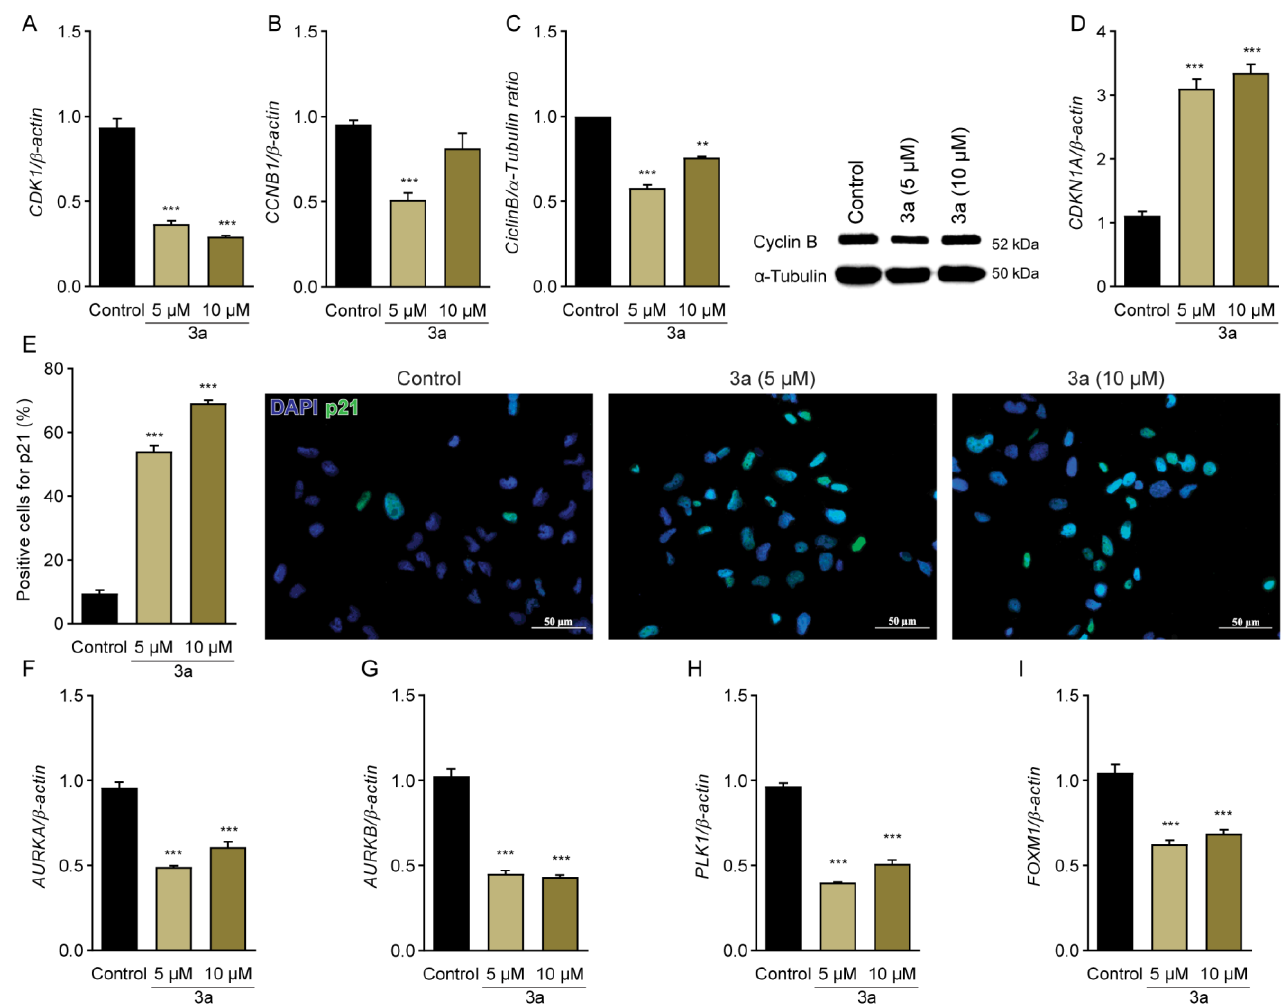
Figure 4. Compound 3a increased the expression of p21 and decreased the expression of aurora kinases. SK-MEL-147 cells were treated with 3a at 5 and 10 µM for 24 h and relative expression of target genes was evaluated by qPCR ( A – I ), immunoblot ( C ), or immunocytochemistry ( E ). ( A ) Relative CDK1 mRNA expression; ( B ) Relative CCNB1 mRNA expression; ( C ) Relative CCNB1 at protein levels; ( D ) Relative CDKN1A mRNA expression; ( E ) Frequency of p21-positive cells determined by immunofluorescence. Blue: DAPI; green: p21. ( F ) Relative AURKA mRNA expression; ( G ) Relative AURKB mRNA expression; ( H ) Relative PLK1 mRNA expression; ( I ) Relative FOXM1 mRNA expression. ** p < 0.01 and *** p < 0.001 according to ANOVA followed by Dunnet post-test compared with control group.